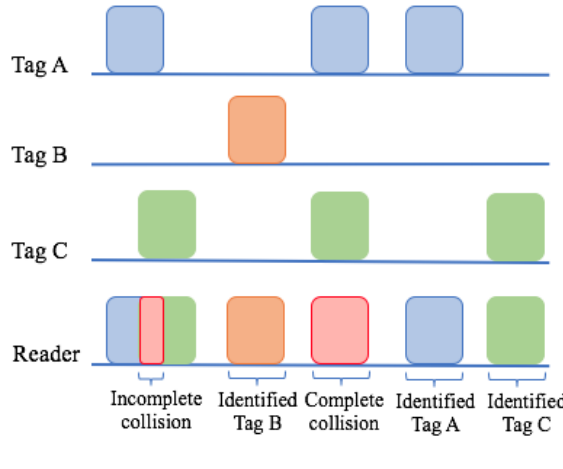
Figure 8. An example of